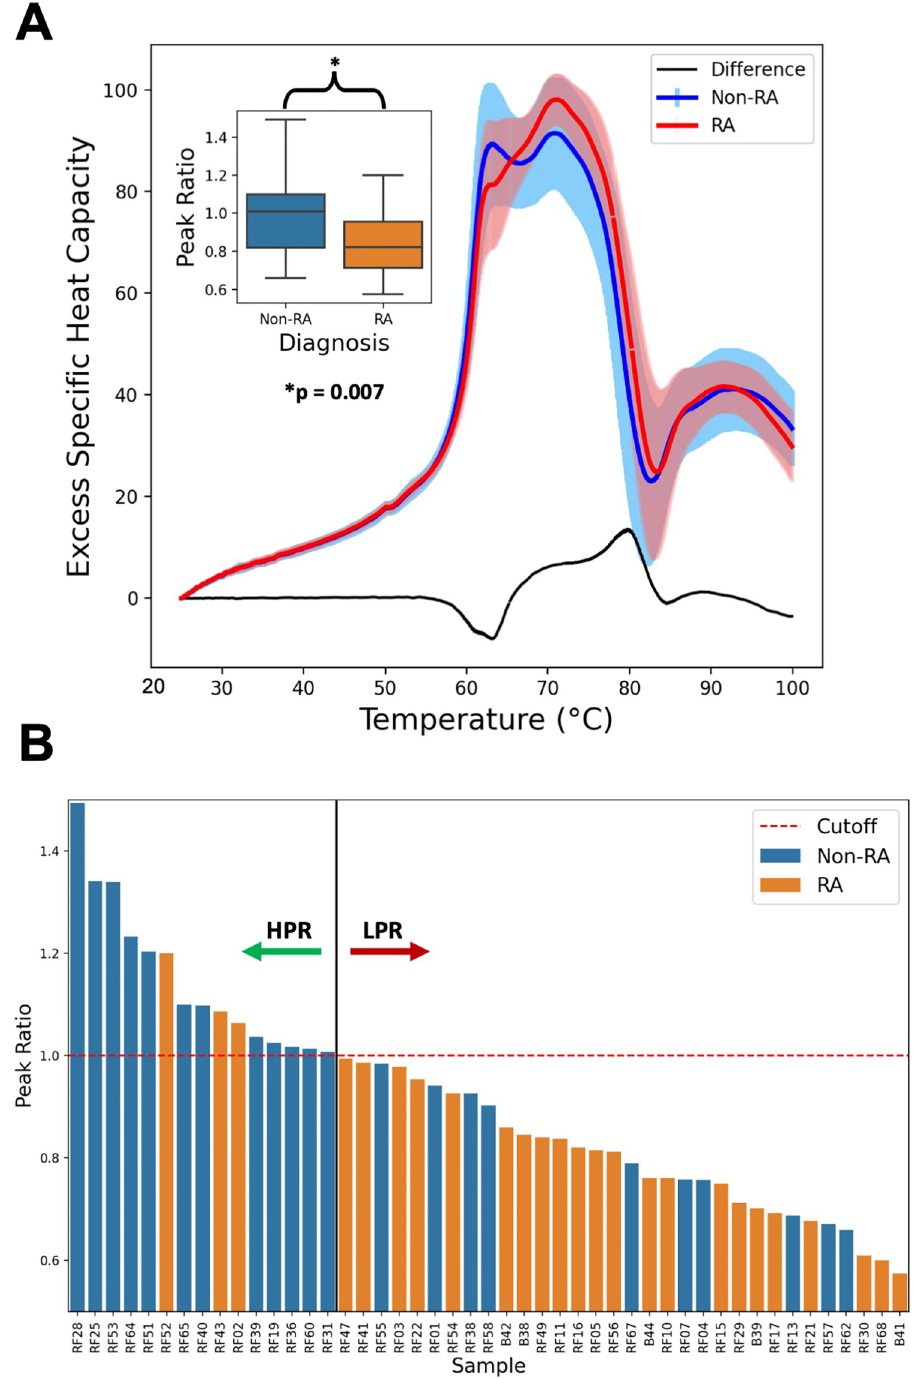
Fig 3. DSC results. This study focuses on the two peaks observed between 55 and 75˚C of the heat denaturation curve. (A) The average normalized HDC curve for non-RA and RA samples, with the difference between the two shown in black. The first peak from HSA is consistently found around 63˚C (low temp peak) and the second Ig peak is always around 71˚C (high temp peak). Inset for A shows the distribution of peak ratios from the HDC of RA and non-RA subjects. The difference in peak ratio between the non-RA and RA groups is statistically significant (p = 0.007) (B) The distribution of peak ratio of all samples, with a peak ratio threshold of 1.00 as the cut-off between the HPR and LPR